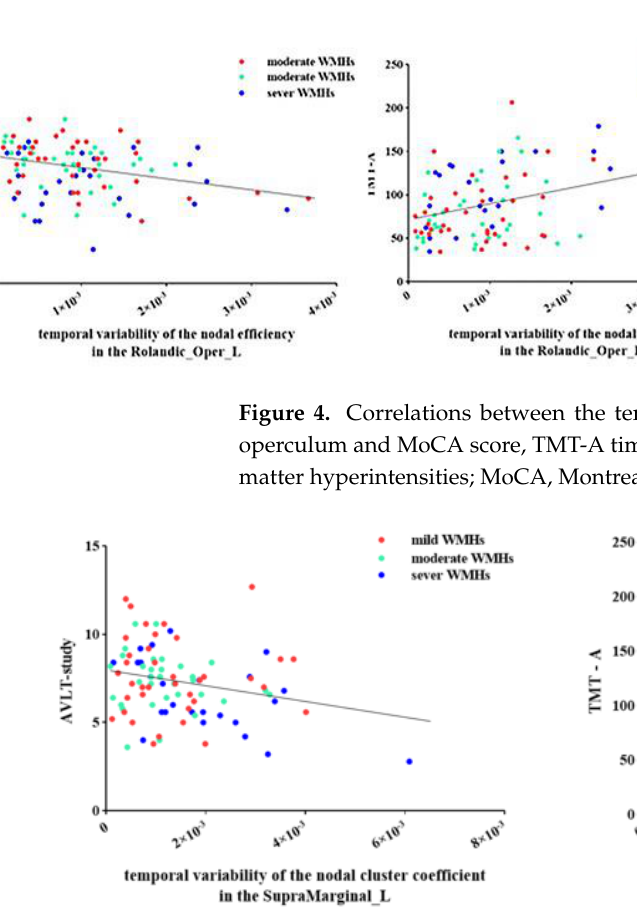
Figure 5. Correlations between the temporal variability of nodal cluster coefficiency in left supra- marginal gyrus and TMT-A time and the score of AVLT-study in patients with WMHs. WMHs, white matter hyperintensities; AVLT, Chinese Auditory Learning Test; TMT, Trail Making Test.